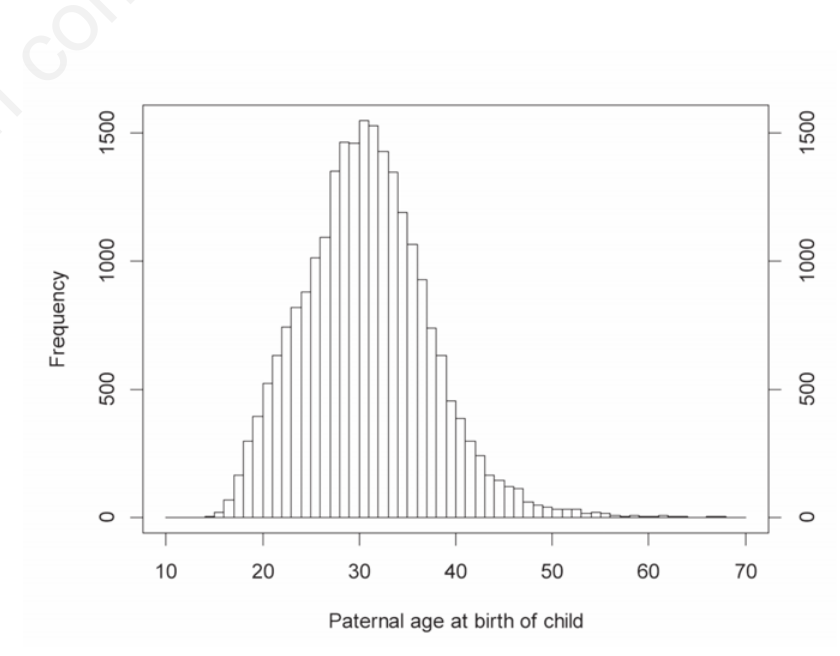
Figure 1. Histogram of paternal age at birth of